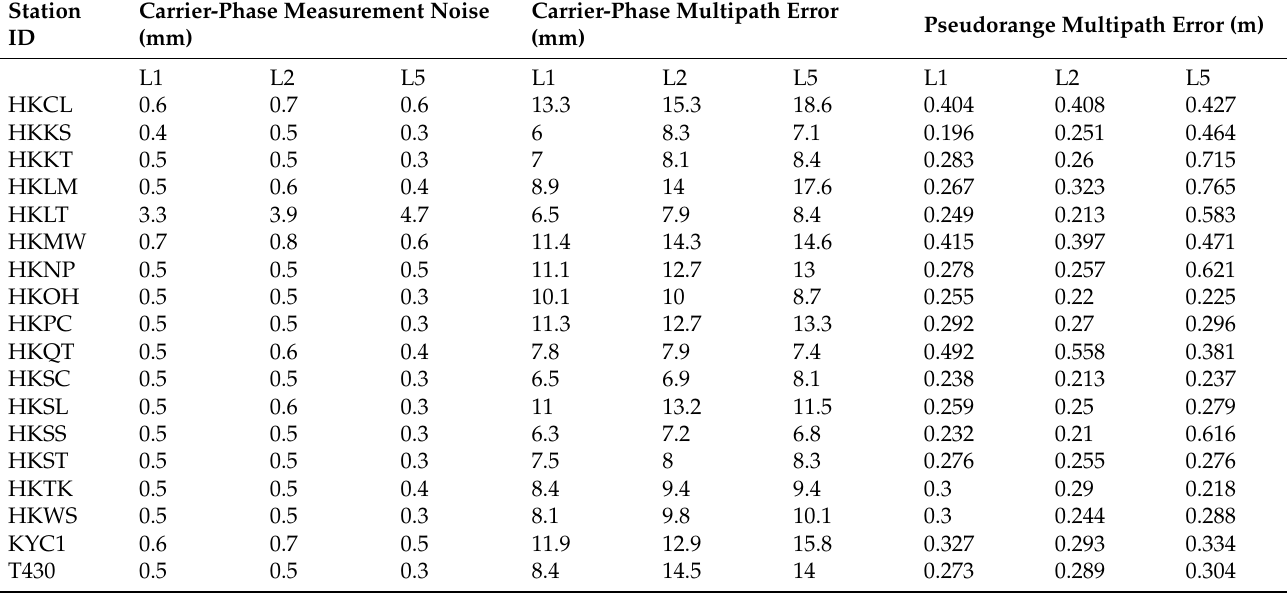
Table A1. Carrier-phase measurement noise, pseudorange, and carrier-phase multipath errors of the Hong Kong SatRef GPS three-frequency measurements at a 95% confidence level.